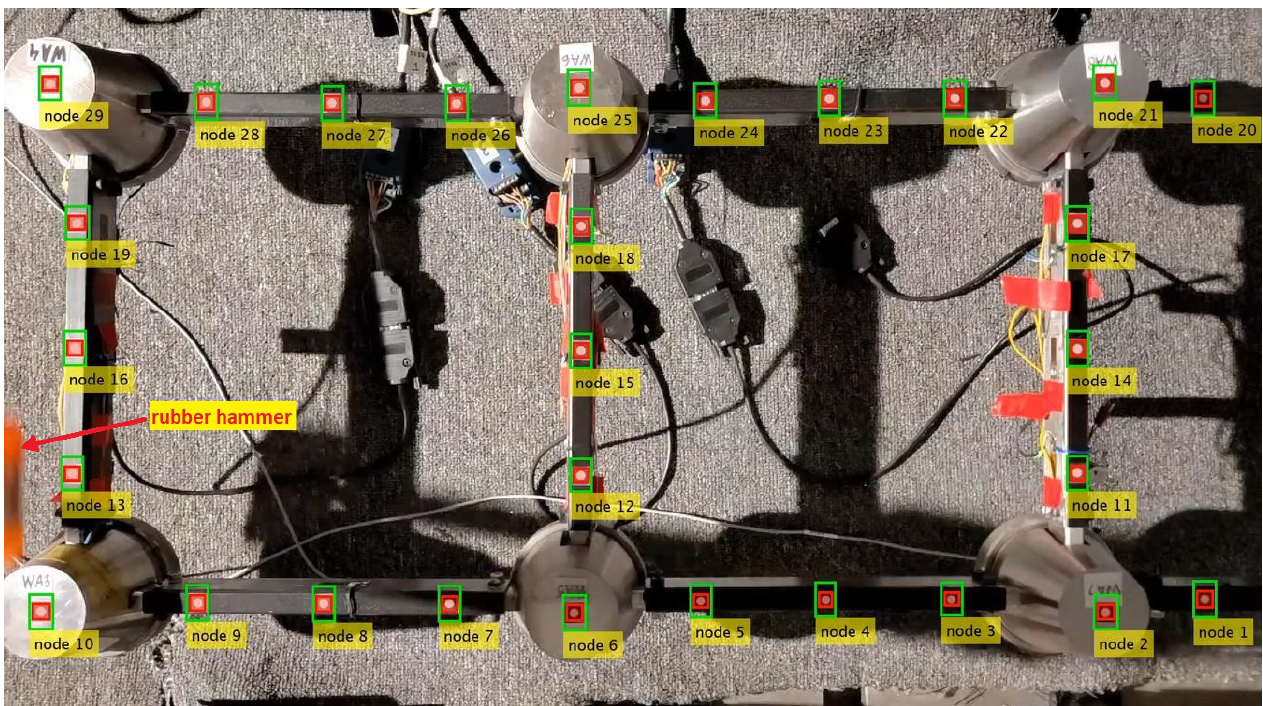
Figure 5. Example of the video frame registered by the smartphone camera accompanied by the numeration of the nodes to be tracked, manually selected templates (red rectangles), ROIs (green rectangles) and the location of the unmeasured impact excitation by a rubber